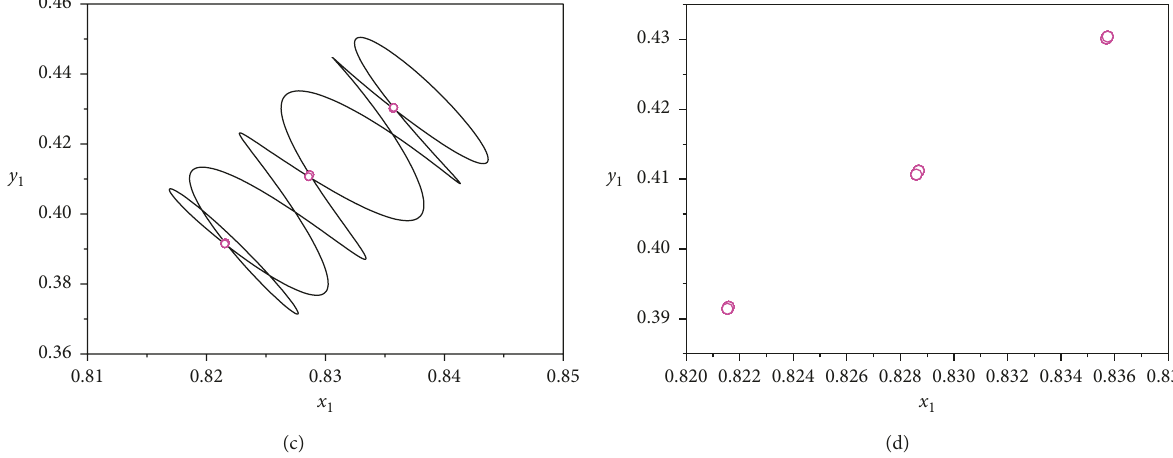
Figure 12: ω � 1.20 and η � 0.167: (a) displacement response; (b) frequency spectrum; (c) rotor orbit; (d) Poincar´e maps.